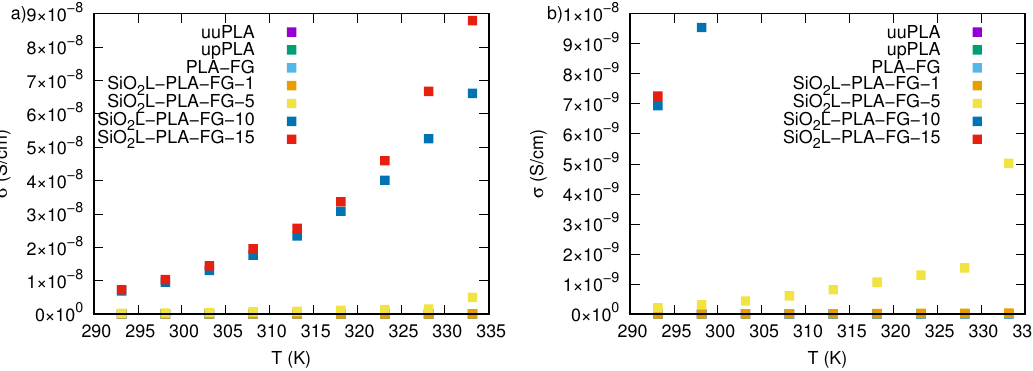
Figure 9. The dependence of the electrical conductivity at 0.1 Hz on the temperature of the unfilled and SiO 2 L-PLA-FG nanocomposites: ( a ) for the entire electrical conductivity range, ( b ) for the electrical conductivity range between 0 and 10 − 8 Scm − 1